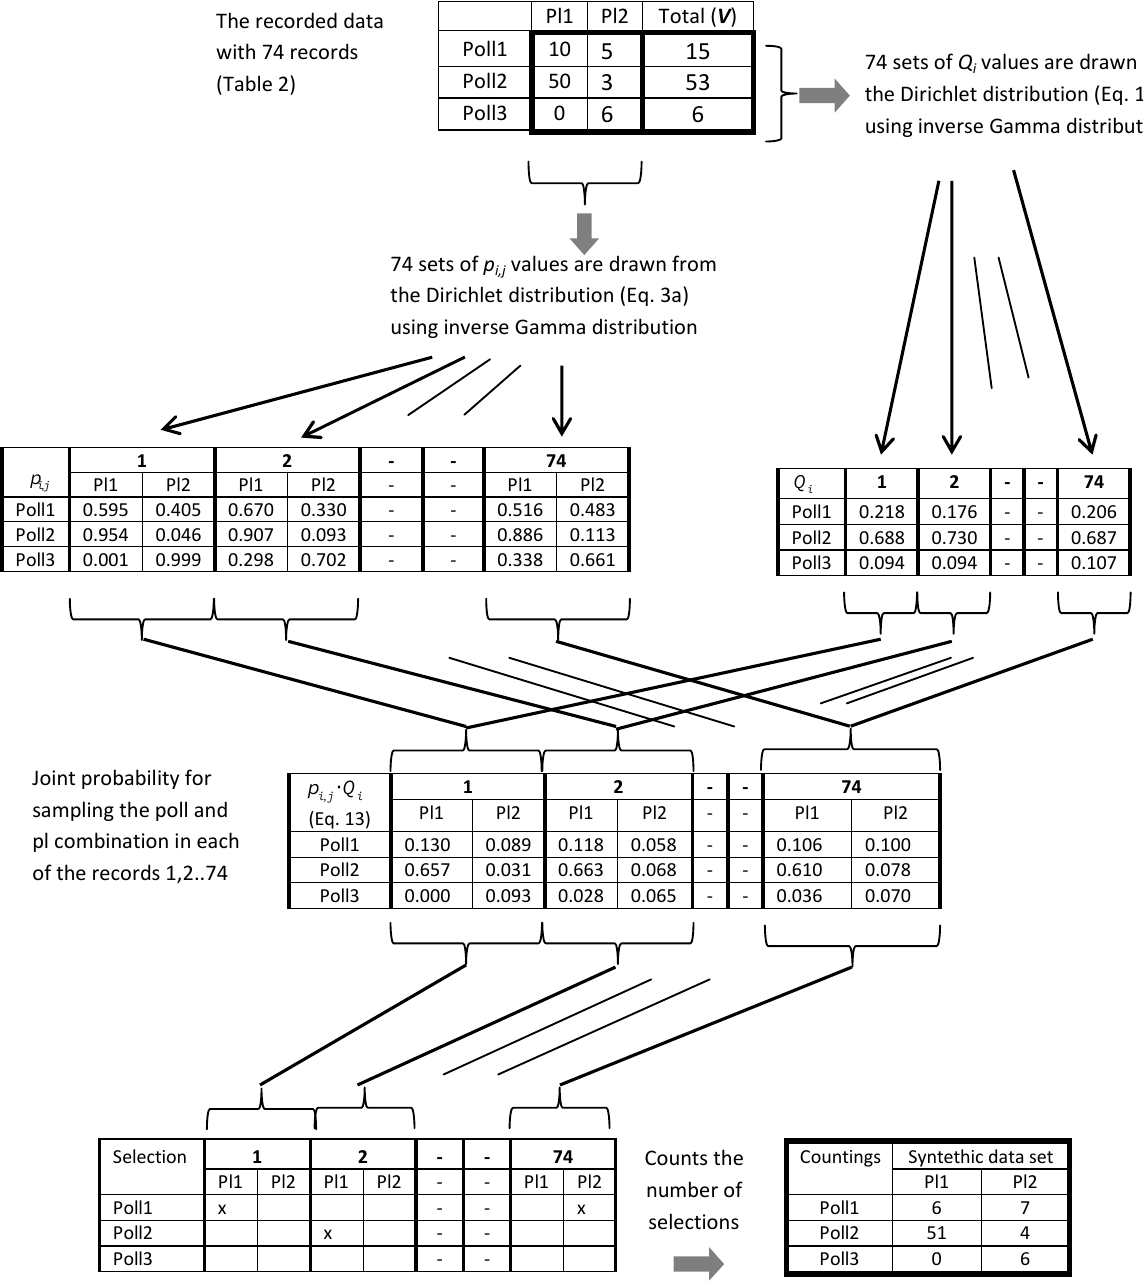
Figure 5. Principle of resampling of 74 records to generate a synthetic data set on basis of the data set shown in Table 2. The original data set is used in the inverse Gamma distribution to draw stocastgically 74 set of respectively, Q and p are multiplied (Eq. 13) and used to make a biased random selection of which pollinator to “sample”. distributions. The values of i ji, Thus, if 1,11 pQ (cid:215) = 0.130 then there is a 13.0 % change to “sample” the Poll1/Pl1 combination. Finally all the “synthetic” observations are counted to yield the synthetic data set for 74